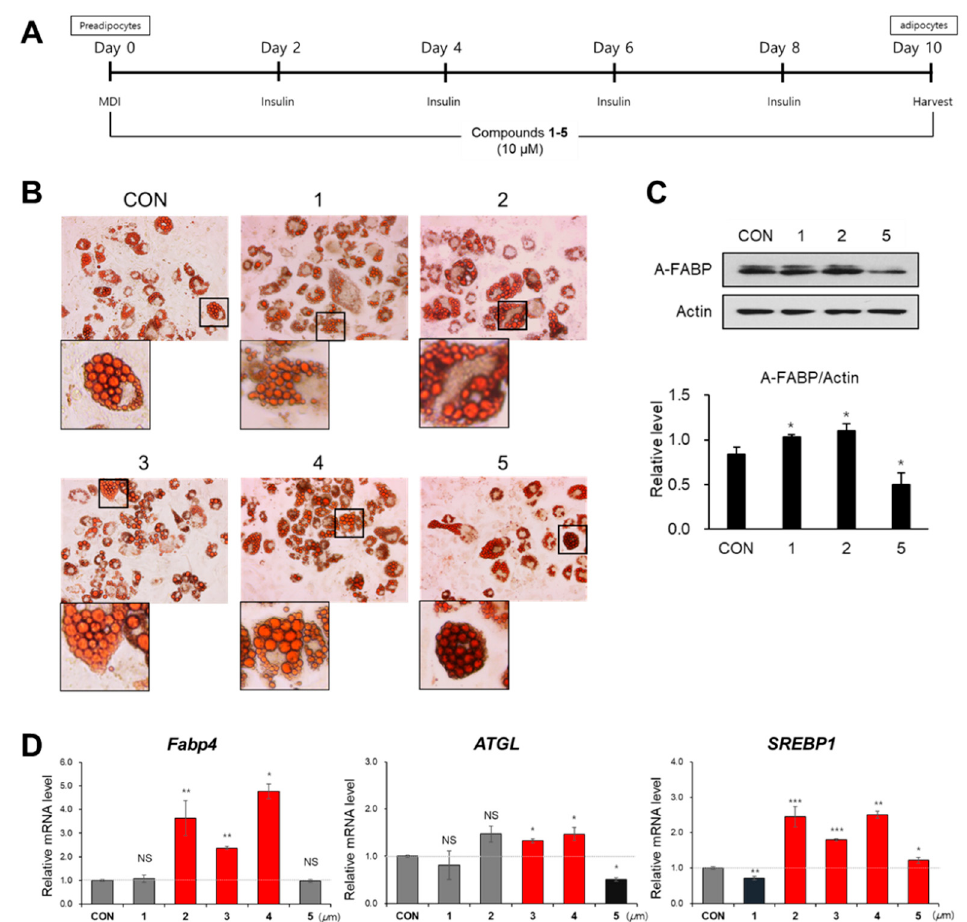
Figure 3. Evaluation of effects of compounds 1–5 on adipogenesis. ( A ) Schematic representation of 3T3-L1 differentiation into adipocytes. ( B ) Oil Red O staining of 3T3-L1 adipocytes incubated with 10 μ M of compounds 1–5 during adipogenesis. ( C ) Immunoblot analysis of 3T3-L1 adipocytes incubated with 10 µ M of compounds 1 , 2 , and 5 during adipogenesis. ( D ) Relative mRNA expression of Fabp4, ATGL, and SREBP1 in 3T3-L1 adipocytes incubated with 10 μ M of compounds 1–5 during adipogenesis. The data represent the mean ± SEM for n = 3. * p < 0.05, ** p < 0.01, *** p < 0.001.